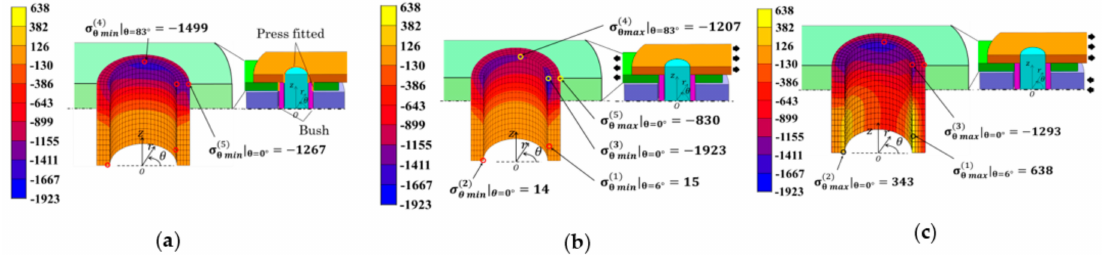
Figure 5. Stress distribution σ θ for the bush [MPa]: ( a ) press-fitting state; ( b ) tensile state; ( c ) engaging state.